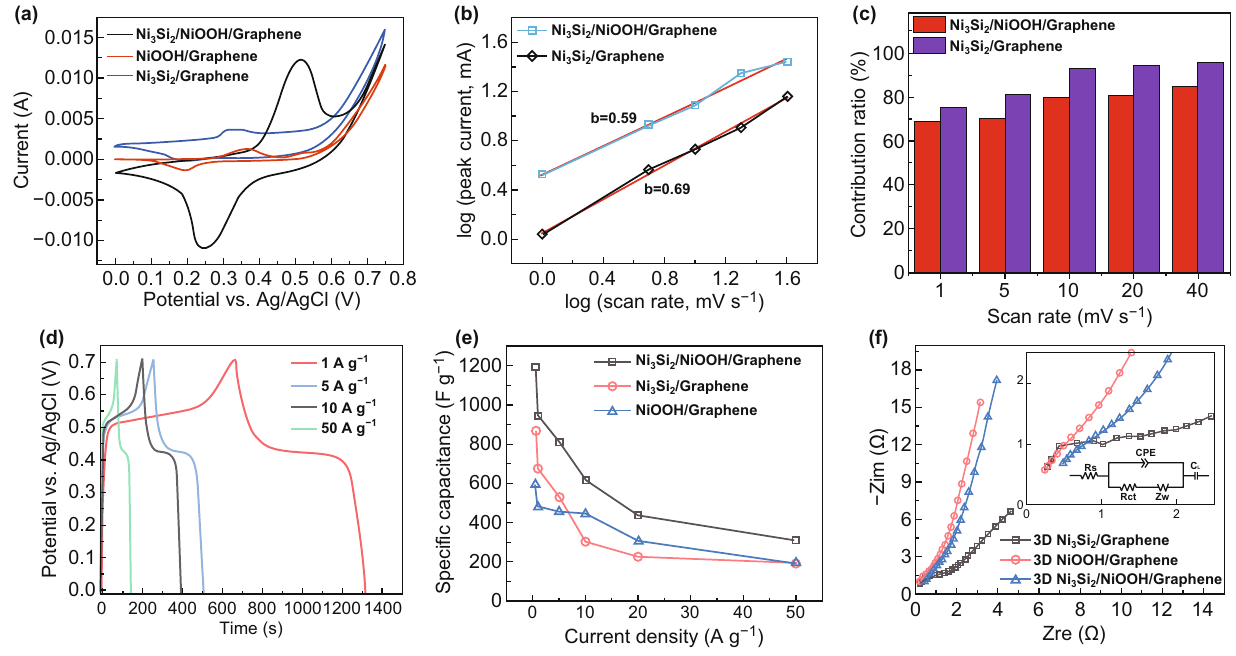
Fig. 6 a Cyclic voltammetry (CV) curves at 10 mV s −1 . b Log (scan rate) versus log (peak current) graph for the anodic peaks. c Pseudocapaci- tive contribution (%) at different scan rates. d Galvanostatic charge/discharge (GCD) curves at various current densities. e Specific capacitance depending on the current density. f Nyquist plots of Ni 3 Si 2 /NiOOH/graphene, Ni 3 Si 2 /graphene, and